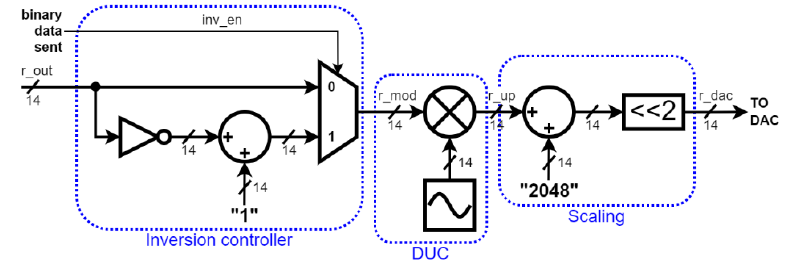
Figure 11. Modulation and signal processing before transmission structure. The arithmetic inversion of digital data values stored in fixed-point two’s complement format is performed in two simple steps—bits are bitwise inverted, and a 1 is added. A multiplexer is used to select which type of chaotic signal is passed further, direct or inverted, selected by the value of binary data